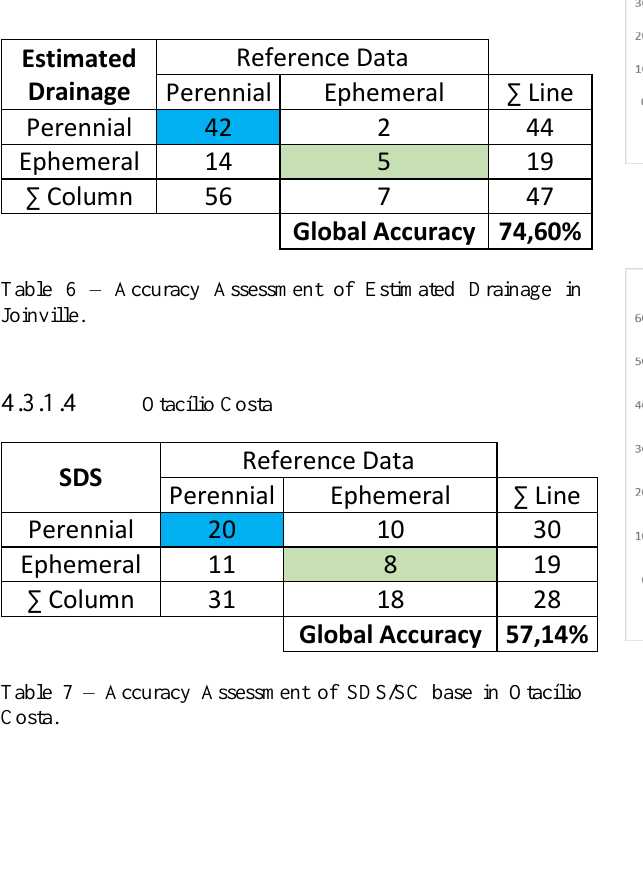
Table 5 – Accuracy Assessment of SDS/SC base in Joinville.